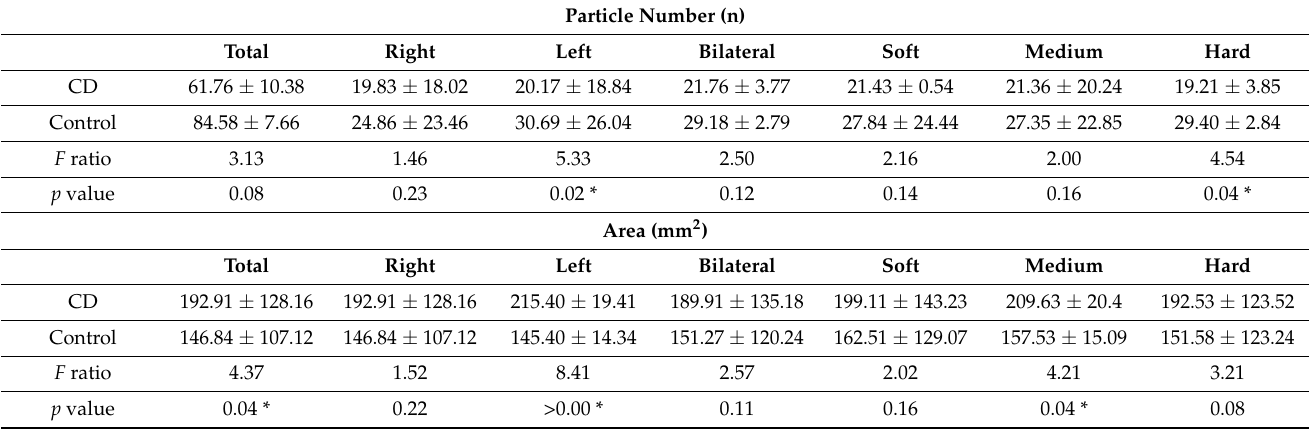
Table 2. Results of masticatory efficiency for patients with craniofacial disorders (CD, n = 42) in comparison to the control group (n = 77) in different chewing cycles. Mean and standard deviation of particle number (n) and area (mm 2 ) was given for the different cycles. These are differentiated by the chewing side and employed sample body hardness: total (all nine chewing cycles), right/left/bi- Right lateral (three chewing cycles within each hardness level) and soft/medium/hard (three chewing cy- cles within each chewing side). Statistical significance was considered at p < 0.05 and denoted with (*).